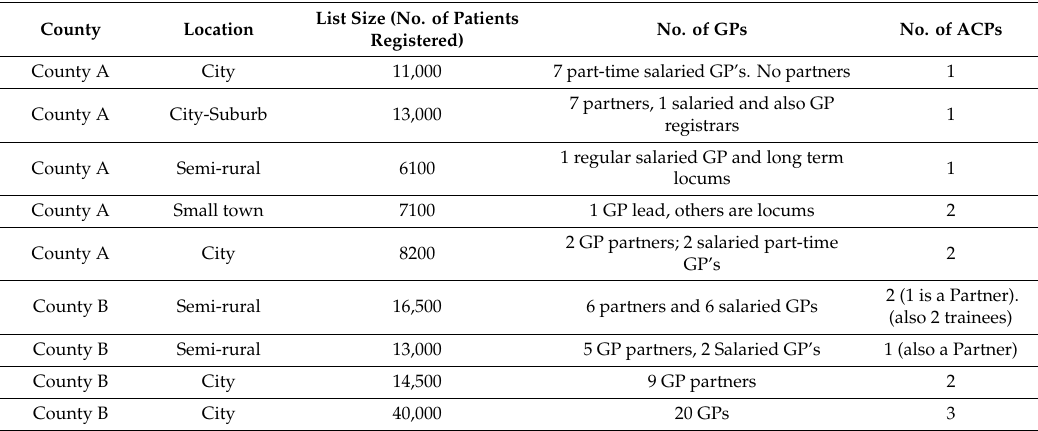
Table 1. General practitioner (GP)